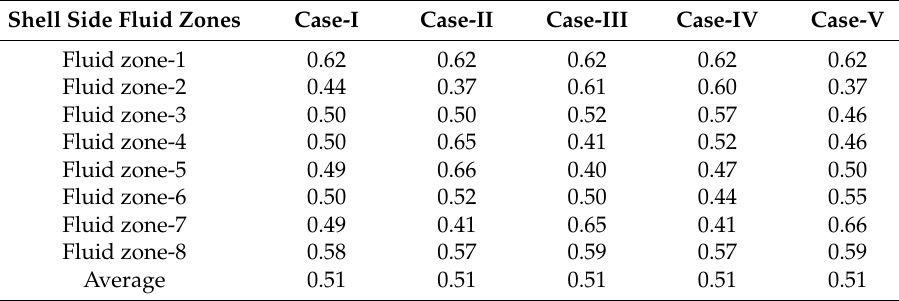
Table 8. CFD results of velocity distribution for each fluid zone